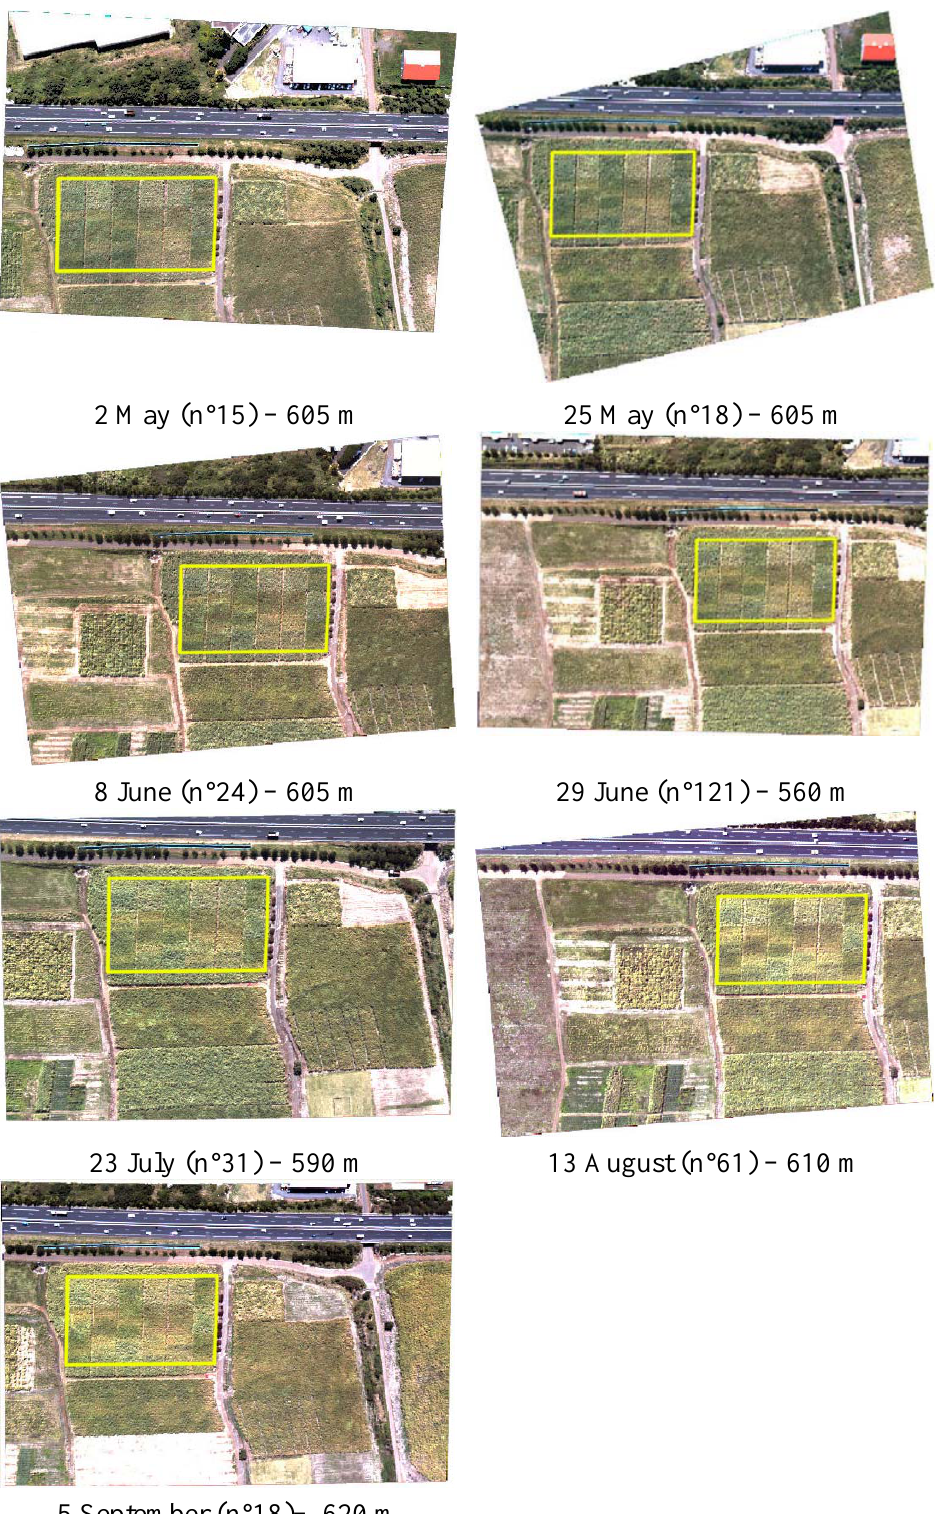
Figure 6. “La Mare” time series of visible images (BGR) taken at an aircraft altitude between 560 m and 620 m. The experimental field is identified by a yellow